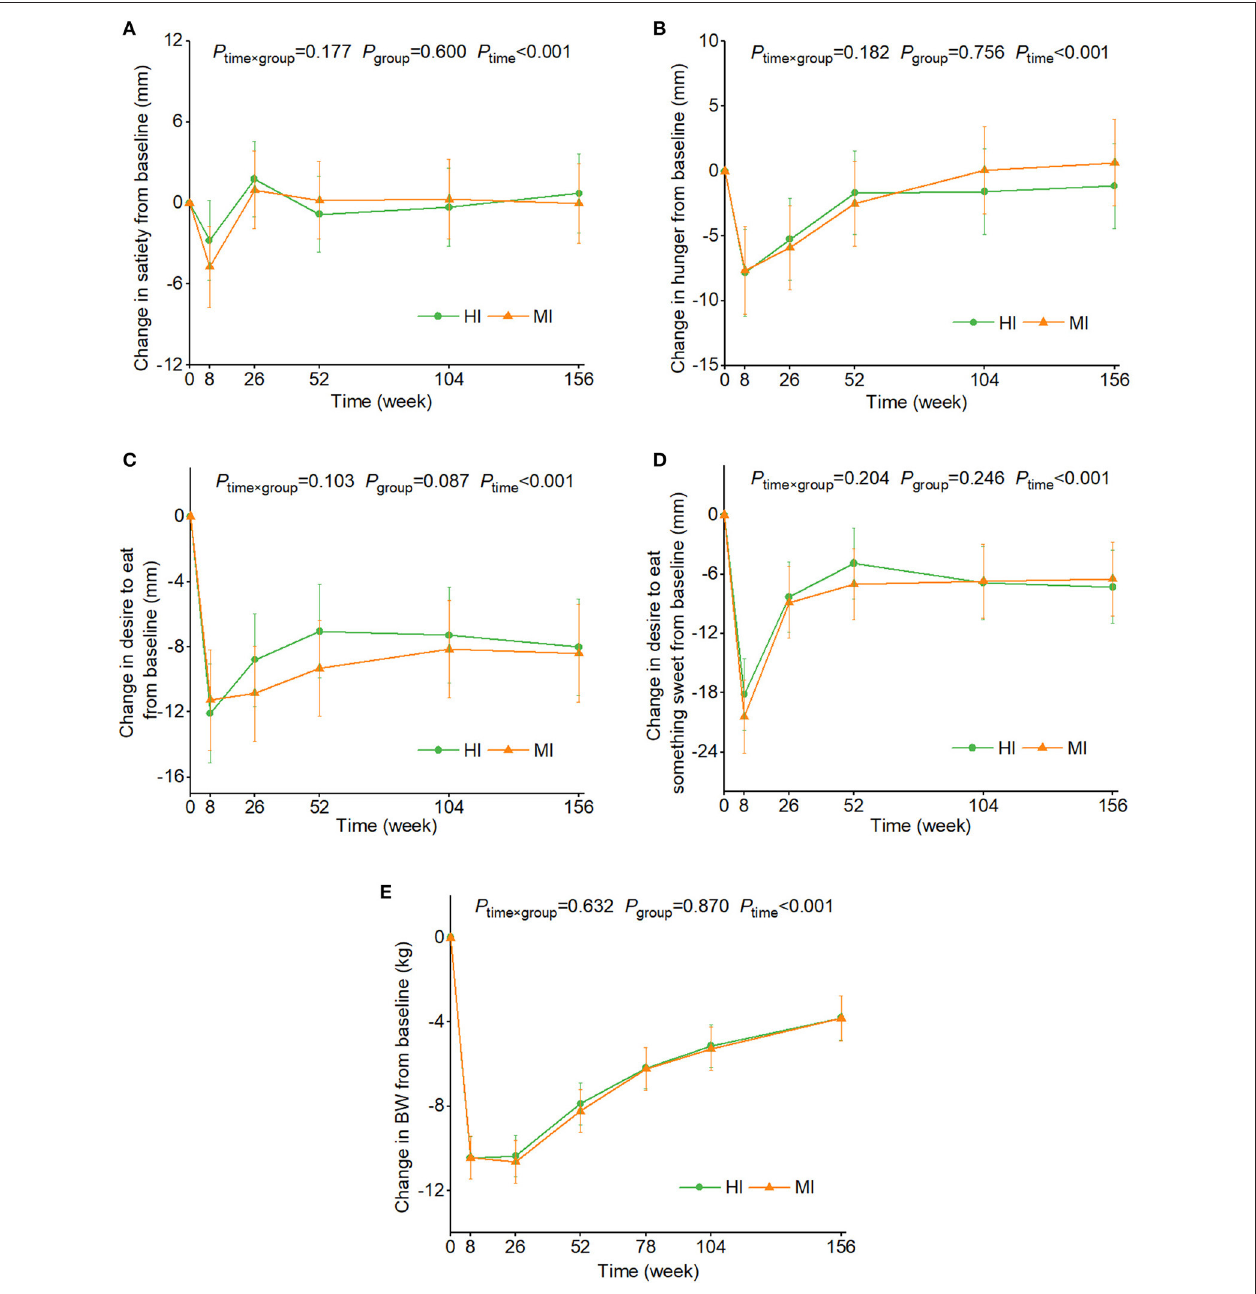
FIGURE 3 | Estimated marginal means and 95% CI in changes in ratings of satiety (A) , hunger (B) , desire to eat (C) , and desire to eat something sweet (D) , and body weight (E) over time by two physical activity groups. Analyses were performed using a linear mixed model with repeated measures adjusted for age, sex, ethnicity, diet groups, baseline appetite ratings (0 weeks), and time as fixed effects and participant-ID and intervention center as random effects. Time × group or group × sex or group × age interaction terms were added. If the interaction was significant, post hoc pair-wise comparisons were conducted at each time point. Values with the different lowercase letters were significantly different, P < 0.05. No group × sex or group × age interaction was observed. BW, body weight; HI, high intensity physical activity; MP, moderate intensity physical